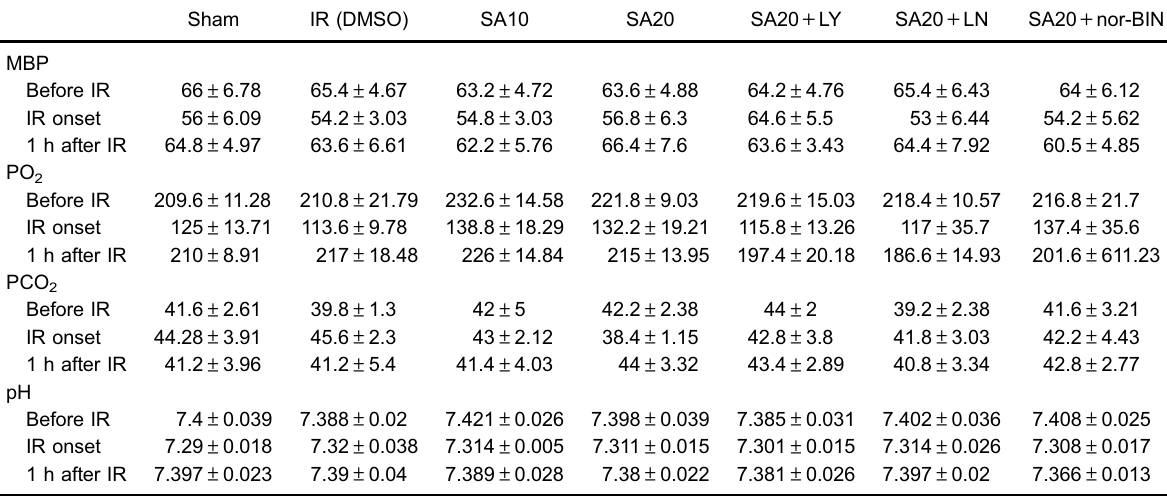
Table 1. Blood pressure, gas tension, and pH before ischemia reperfusion (IR), IR onset, and 1 h after IR. Sham IR (DMSO) MBP Before